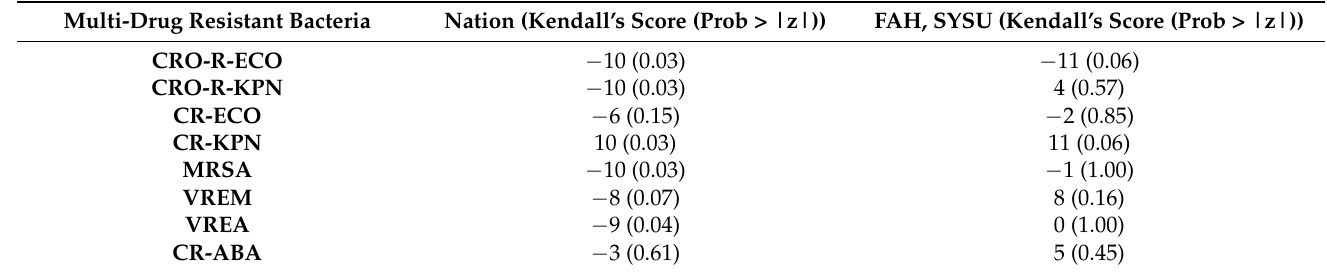
Table 1. Comparison between trends in the detection rate of multiple antibiotic-resistant bacteria among patients with bloodstream infection at FAH, SYSU from 2013 to 2018, and nationally reported trends in detection rates for multiple antibiotic-resistant bacteria between 2014 and 2018.